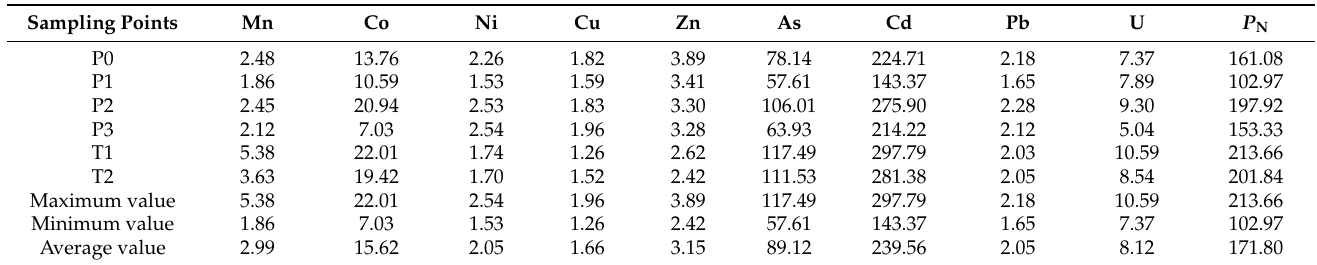
Table 6. Statistical table of the improved Nemerow comprehensive pollution index for uranium and heavy metals in the soil of a uranium mining area in northern Guangdong.